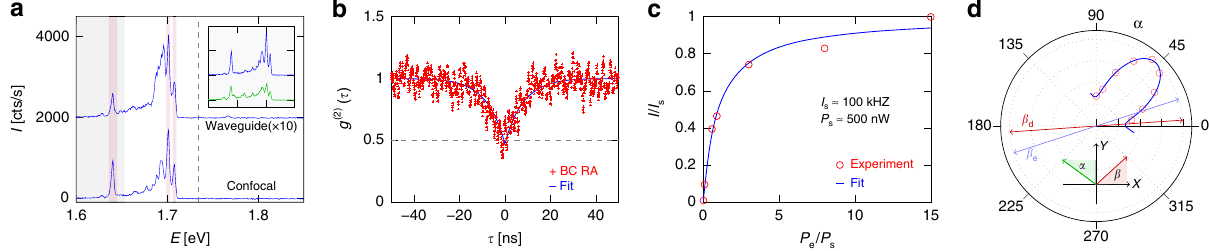
Fig. 3 On-chip single photon emission. a Confocal and waveguide-coupled spectrum of spot S5, excited with λ = 702 nm. The waveguide spectrum is multiplied by 10 and offset by 2000 cts/sec for improved visualization. Common peaks are highlighted by the shaded purple regions. A 715 nm (1.73 eV) longpass fi lter, marked by the dashed line, was used to fi lter the pump. For the g (2) ( τ ) measurement a 750 nm (1.65eV) longpass fi lter (gray shaded area) was used to isolate the single emitter at 756.6 nm (1.64 eV). The inset fi gure shows confocal spectra obtained by either green ( λ = 532 nm) excitation (green curve) or excitation with λ = 702 nm (blue curve). b – d Characterization of the 1.64 eV emitter. b Normalized background-corrected (BC) running average (RA) coincidence counts (red) and g (2) ( τ ) fi t (blue). c Measured intensity saturation (red) and fi t to saturation curve (blue). d Normalized SPD count of the emitter (red) as a function of half-wave plate rotation angle α and fi t to intensity transmission curve (blue); α = 0 corresponds to a half-wave plate fast axis along the Y − direction. See Supplementary Fig. 1 for orientation of the half-wave plate with respect to the ( X , Y , Z ) axes. Based on the fi t, the difference in polarization angle between the PL ( β d ) and excitation ( β e ) beam can be extracted; β = 0 corresponds to a polarization along the X